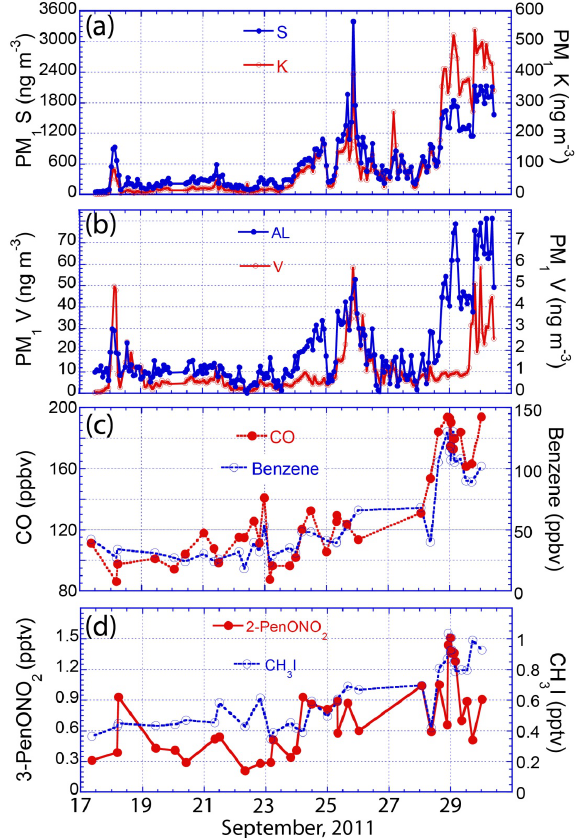
Figure 12. Time series of key elements and gases. (a, b) DRUM time series of sulfur + potassium and aluminum + vanadium, respectively. (c) Carbon monoxide and benzene, both common biomass burning emissions. (d) 2-Pentane oxyl nitrate, a pho- tochemical pentane daughter product and methyl-iodide, a halo- genated organic specie also emitted by burning, the oceans, and used in